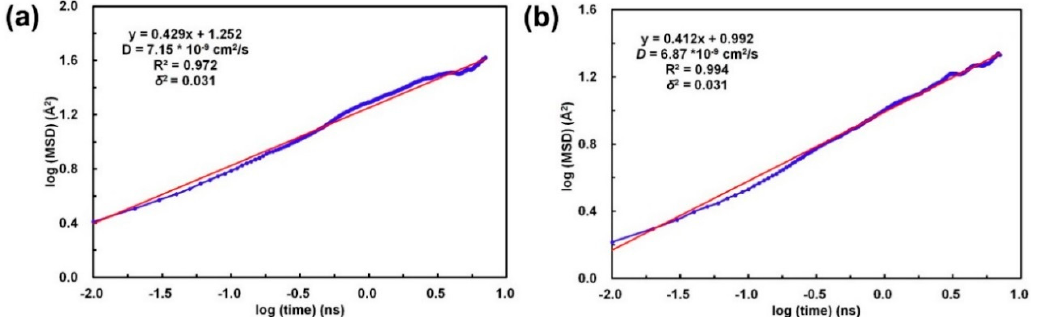
Figure 7. The relationship between log (MSD) and log (t) of CO 2 diffusion in ( a ) EB-PANI and ( b ) Na-SPANI (III).